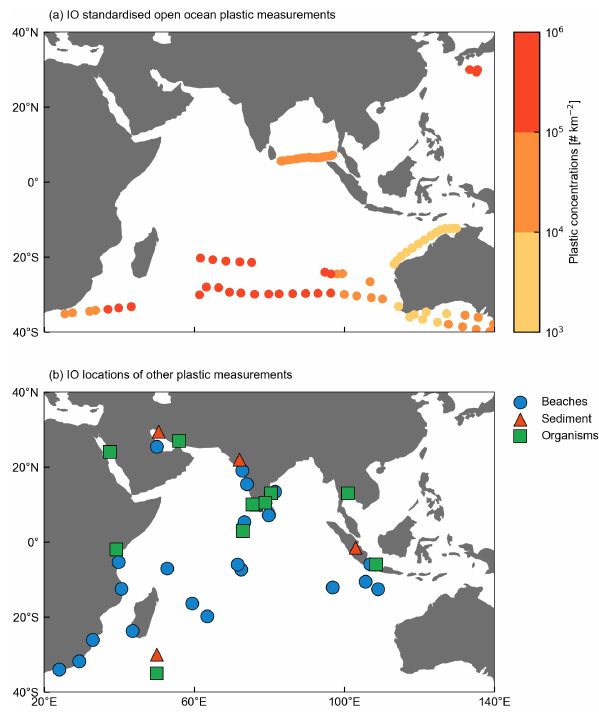
Figure 2. (a) Standardized measured concentrations of plastics in the Indian Ocean. Original samples were performed by Mor- ris (1980), Reisser et al. (2013), Eriksen et al. (2014), and Cózar et al. (2014) and were standardized by van Sebille et al. (2015). (b) Lo- cations of plastic samples taken on beaches, in sediment, and in or- ganisms around the Indian Ocean (references to individual studies listed in Table 1). Because sampling methods vary widely between studies, a quantitative comparison of measured plastic concentra- tions between these studies is not